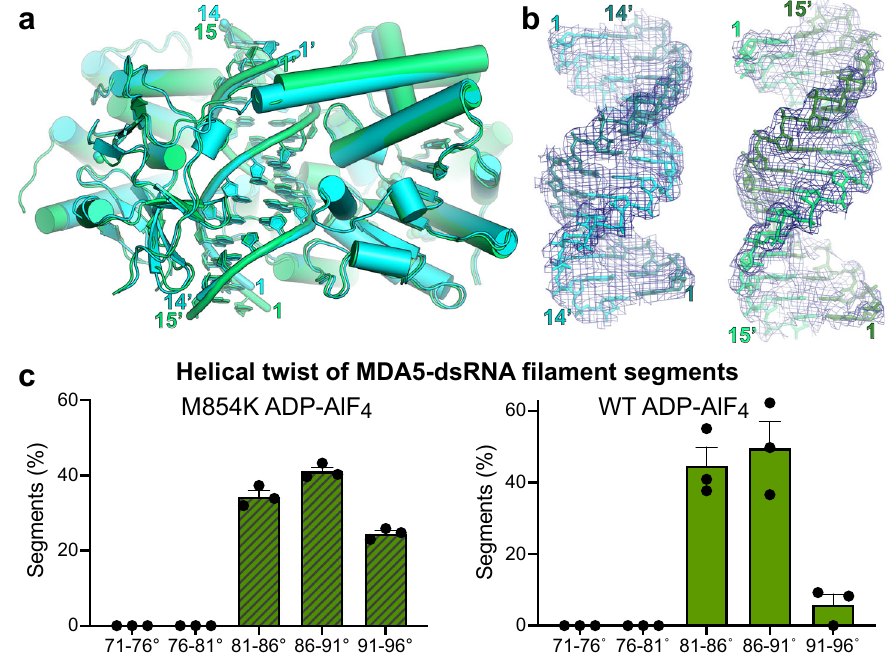
Fig. 4 CryoEM structures of ADP-AlF 4 -bound M854K MDA5-dsRNA fi laments. a Superposition of two atomic models of ADP-AlF 4 -bound M854K MDA5-dsRNA fi laments representing the most populated classes of 3D cryoEM image reconstructions. The class representing the majority of fi lament segments (Class 167k, cyan) contains 14 bp RNA in the asymmetric unit; the minority structural class (Class 62k, green) contains 15 bp RNA. b Atomic models and 3D density maps for the dsRNA for the two structural classes of ADP-AlF 4 -bound M854K MDA5-dsRNA fi laments. Left, Class 167k, 6.8- σ contour level in PyMol; Right, Class 62k, 6.0- σ contour level. c Histograms showing the distributions of fi lament segments as a function of helical twist for M854K and WT MDA5-dsRNA with ADP-AlF 4 bound. The twist distribution for WT is shown for reference and was reported previously 14 . The distributions are from 3D classi fi cations performed with ten classes per dataset. Error bars represent the SEM between 3D classi fi cation calculations, centered on the mean ( n = 3 independent calculations). Source data are provided as a Source Data fi le.